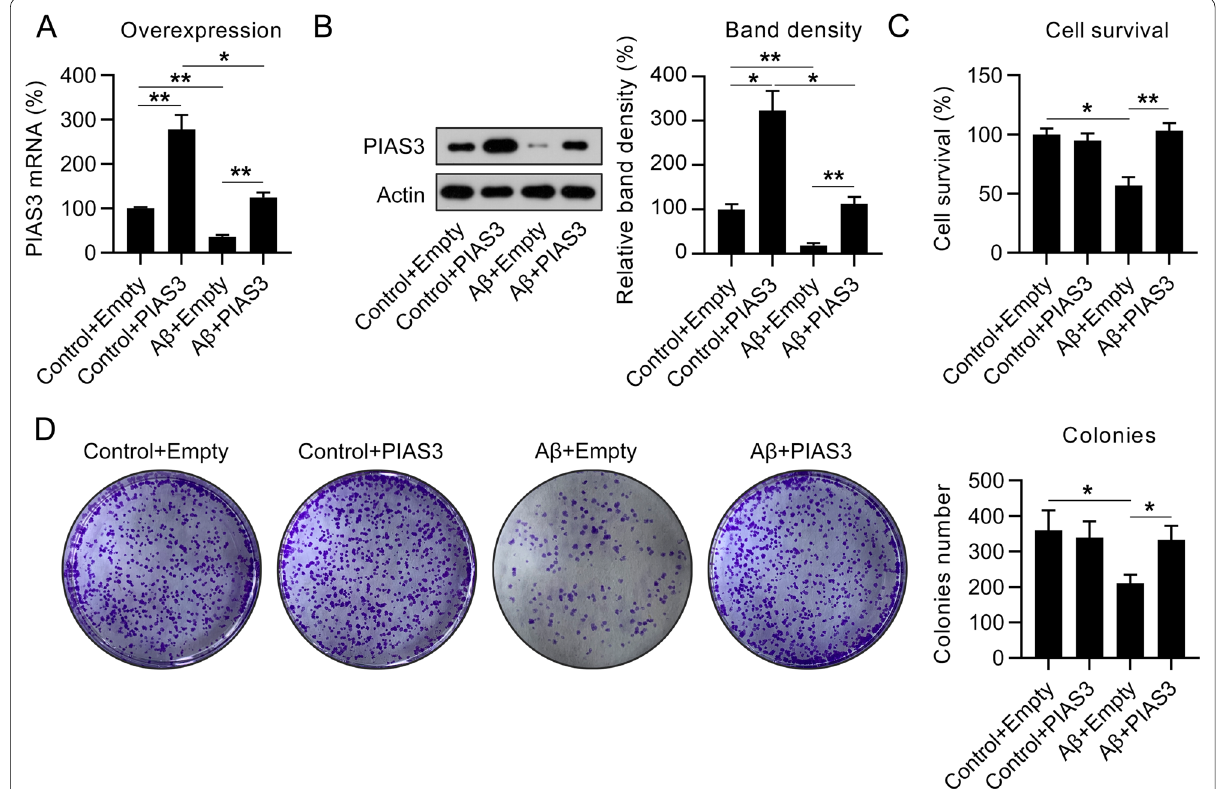
Fig. 2 Effects of PIAS3 overexpression on the survival of Aβ-treated SH-SY5Y cells. Cells were subjected to transfection with a PIAS3 overexpression vector or an empty vector for 1 d, and subsequently subjected to Aβ treatment (20 μM in 0.1% DMSO) for an additional 1.5 d. A , B qPCR and WB were performed to determine PIAS3 expression. C The CCK-8 assay revealed that effects of PIAS3 on cell survival 2 d after treatment. D CFA showed the influence of PIAS3 upregulation on cell growth. Data represent mean SEM. *p < 0.05, **p < 0.01. PIAS3 protein inhibitor of activated STAT3; ± qPCR quantitative polymerase chain reaction, Aβ amyloid beta, WB western blotting, CCK-8 Cell Counting Kit-8, DMSO dimethyl sulfoxide, CFA